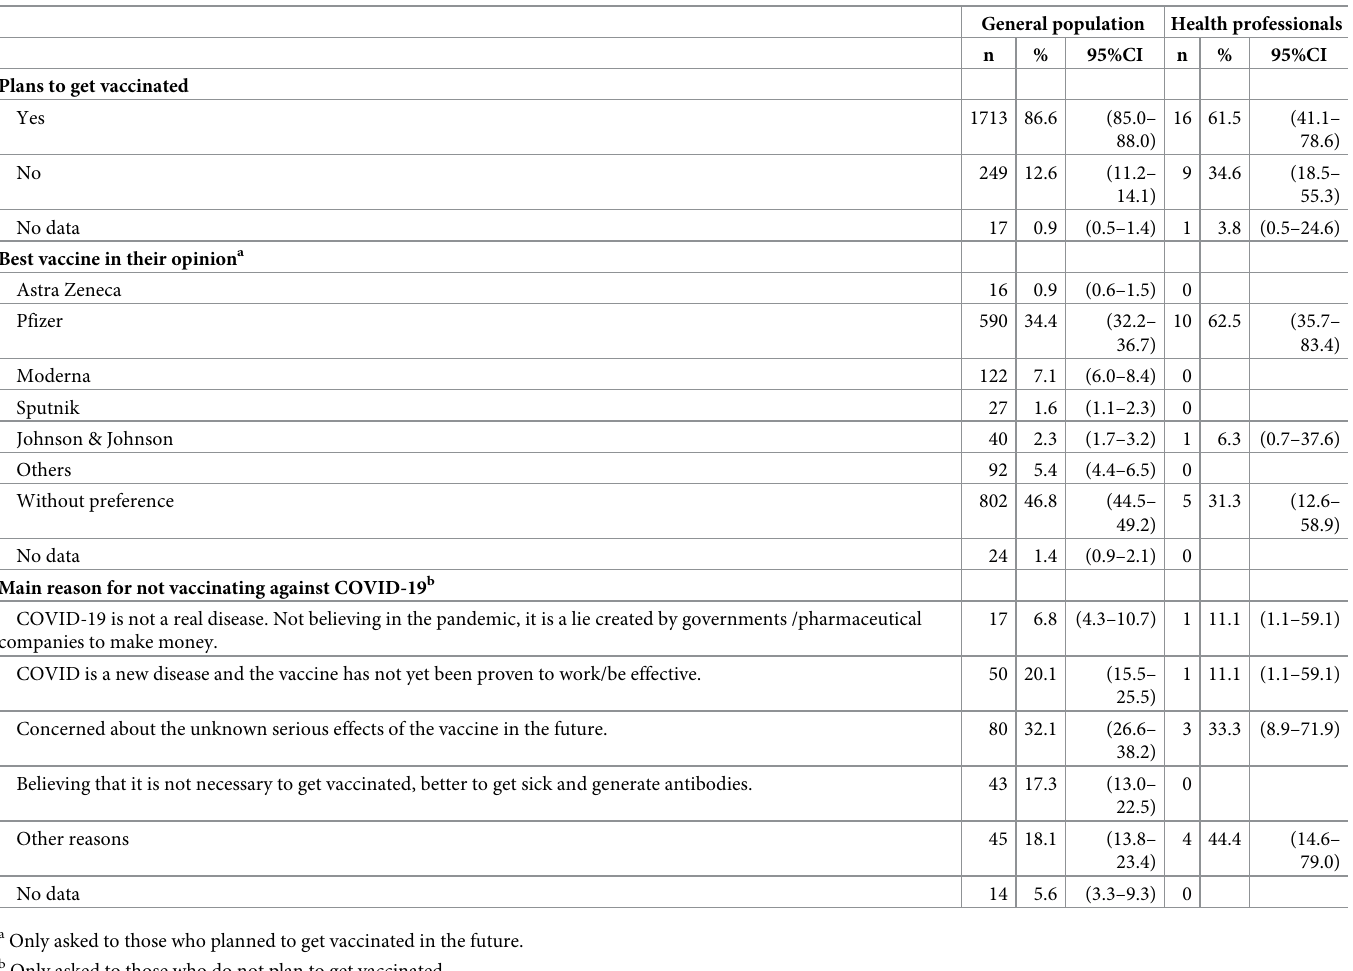
Table 4. Distribution of variables in people who had not been